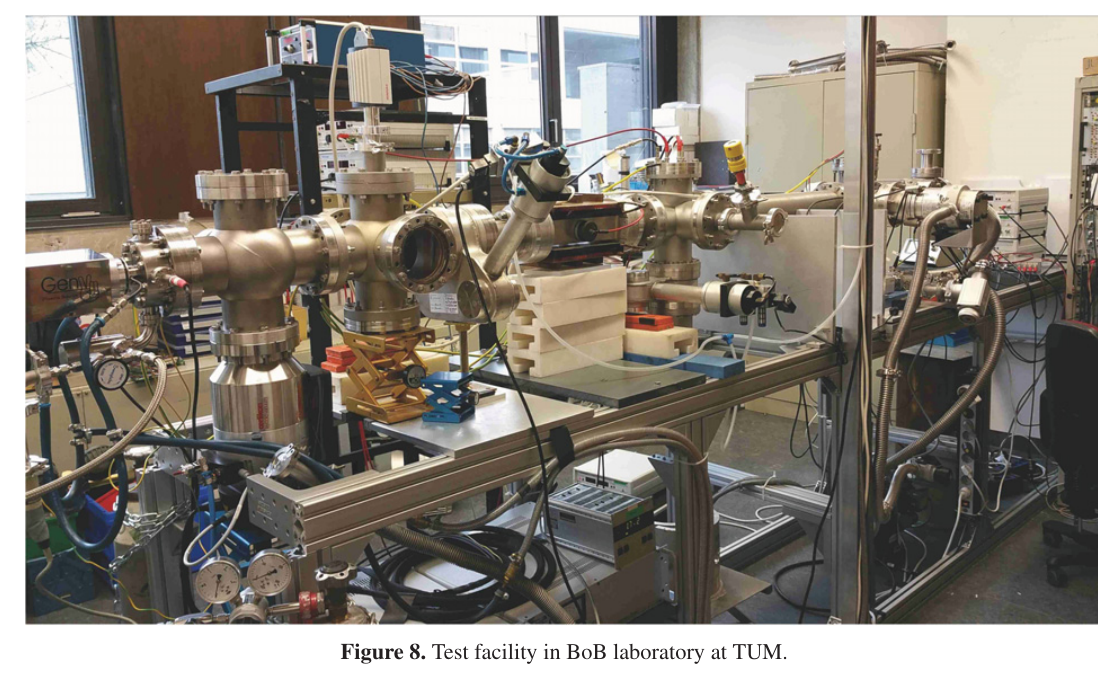
Figure 8. Test facility in BoB laboratory at TUM.